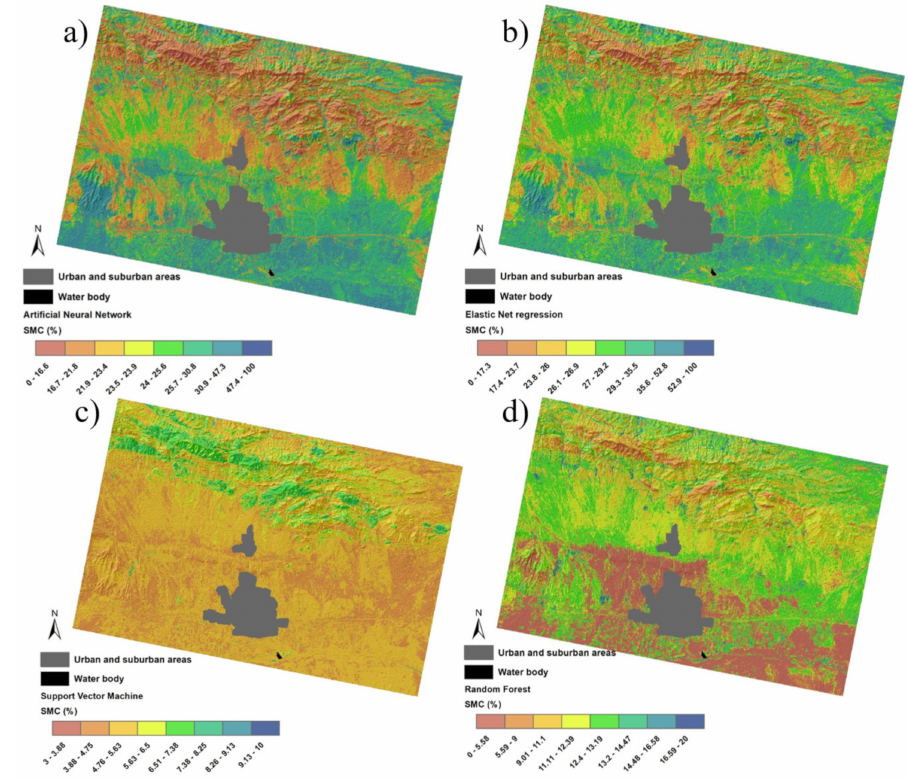
Figure 6. Estimated SMC (%) from Landsat 8 OLI and TIRS data (30 m) using the testing dataset for the study area at 06:42 AM UTC, on 26 May 2017. ( a ) Artificial Neural Network ( b ), Elastic Net regression ( c ), Support Vector Machine, and ( d ) Random Forest. SMC maps overlaid on hillshade using 30 percent